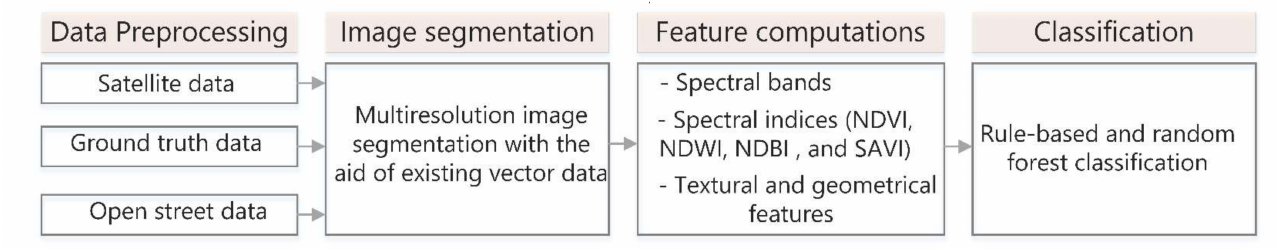
Figure 3. The adopted GEOBIA classification